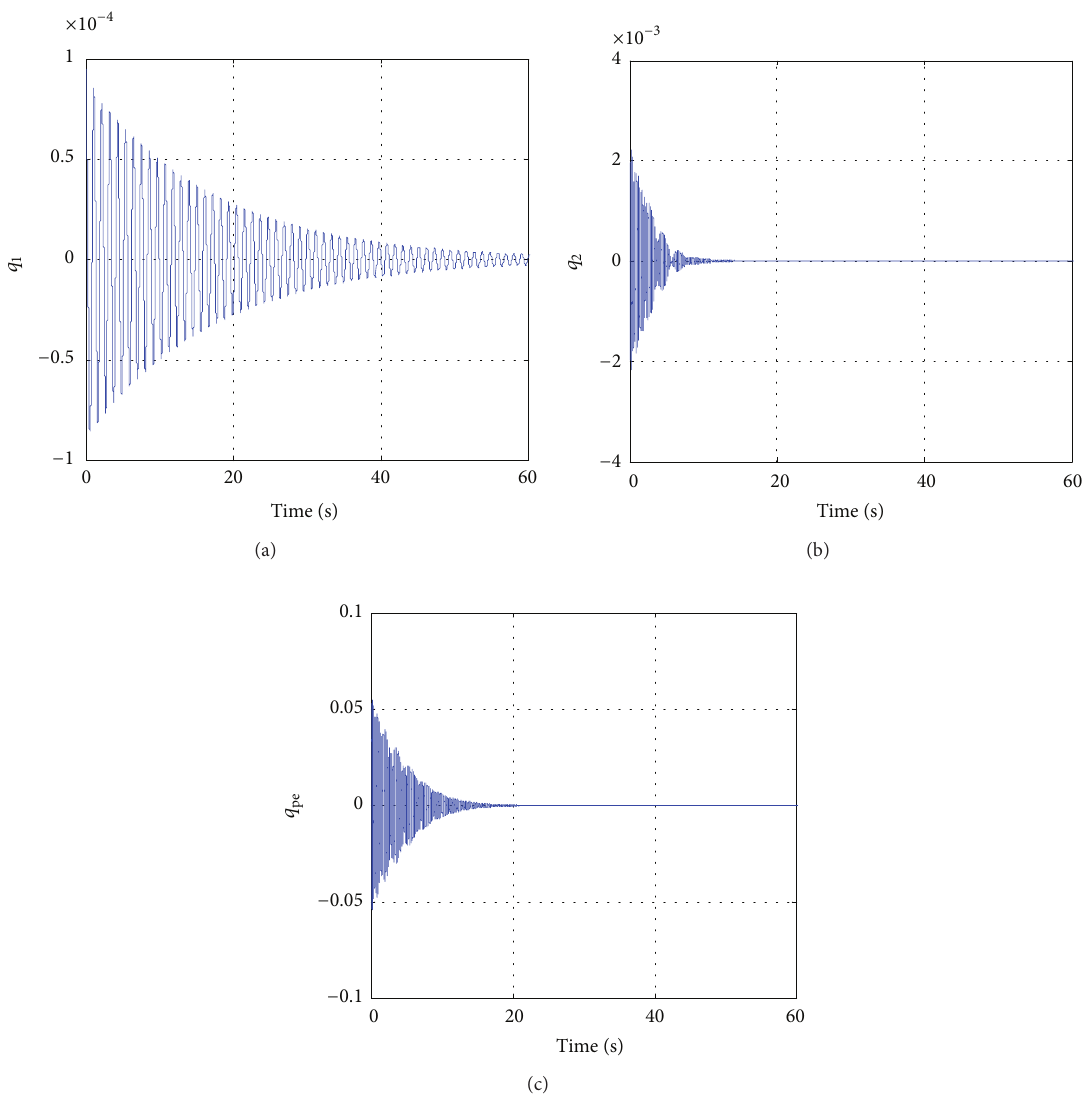
Figure 13: 2I2O system with feedback linearisation: response at 97.5ms −1